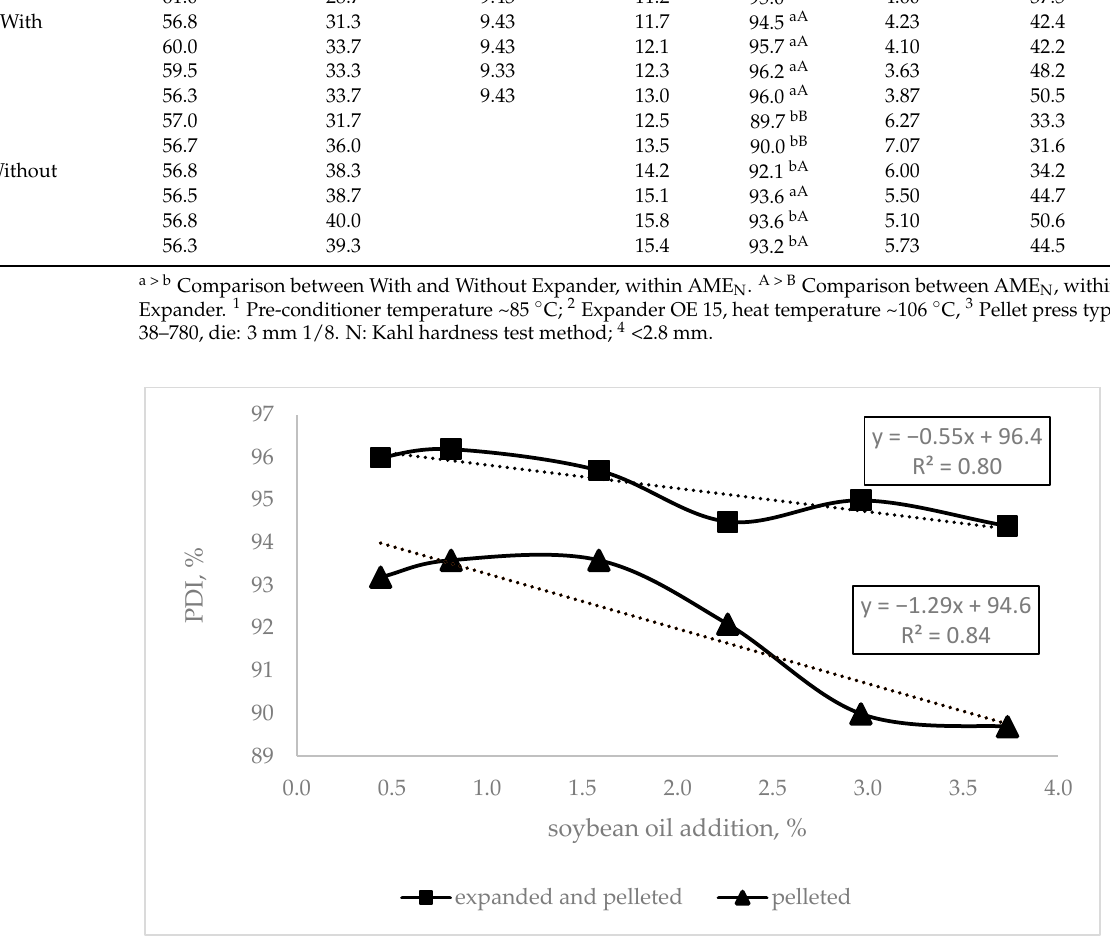
Figure 1. Oil addition (%) effect on pellet durability index (PDI) of pelleted diets conditioned with or without expander prior to pelleting. Table 6. Broiler apparent total tract digestibility (%) and AME N concentration, kcal/kg.